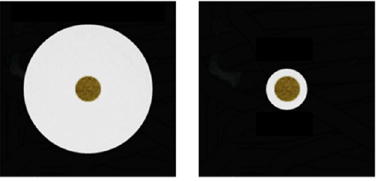
Figure 2. An example of biologically relevant stimuli (i.e., food) that could be used in spontaneous choice studies investigating the Delboeuf illusion in animals.